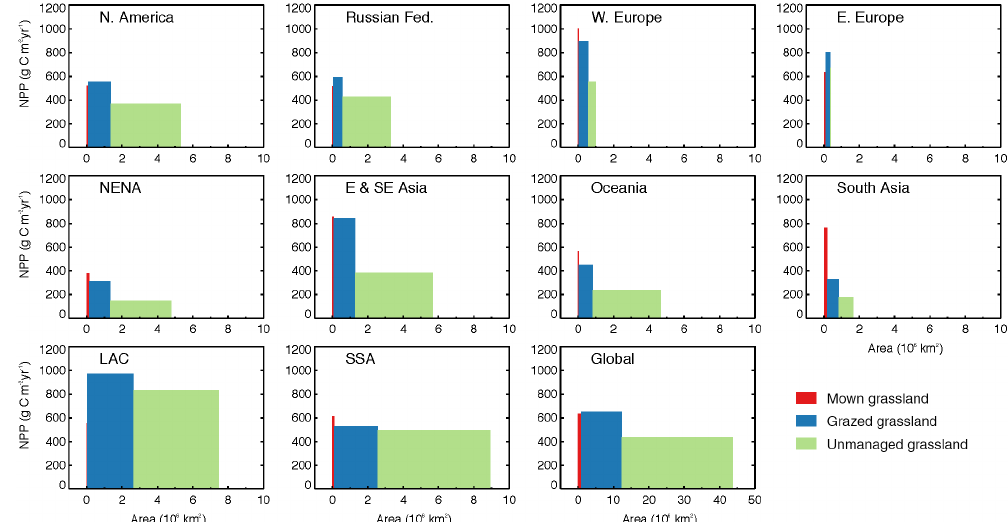
Figure 4. Productivities per unit area (height of each rectangle) and grassland areas (width of each rectangle) of the different types of grassland (mown, grazed, and unmanaged grassland) by FAO-defined regions and global total. Areas in the graph show the production of each grassland type (i.e. Prod mown , Prod grazed , and Prod unmanaged ; see Sect. 3.1 for detail). Productivities and grassland areas are averaged for 1991–2000. The FAO-defined regions (from top-left) are North America, Russian Federation, western Europe, eastern Europe, Near East and North Africa (NENA), East and Southeast Asia, Oceania, South Asia, Latin America and the Caribbean (LAC), and sub-Saharan Africa (SSA).